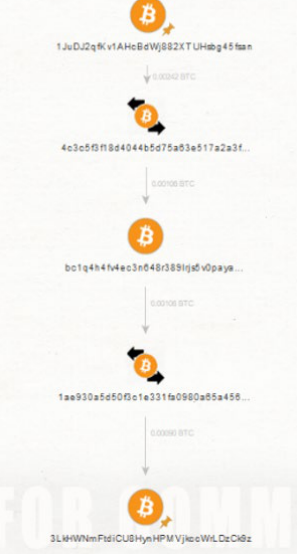
Figure 5. Maltego created visual node diagram.